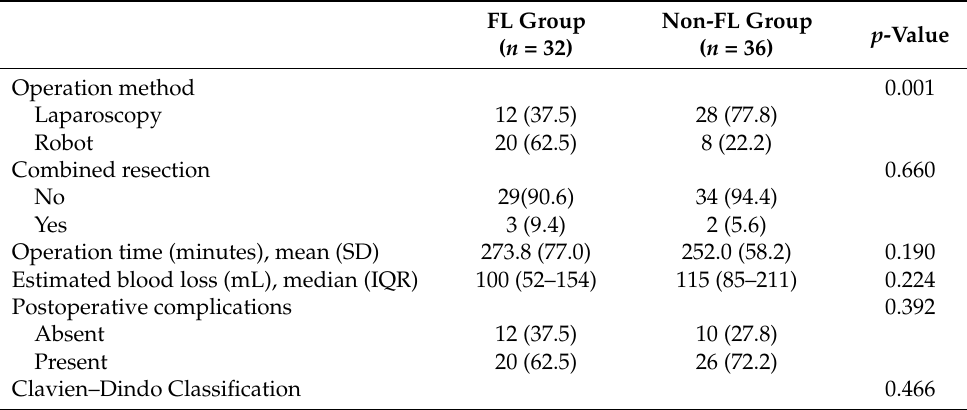
Table 2. Comparison of operative and postoperative